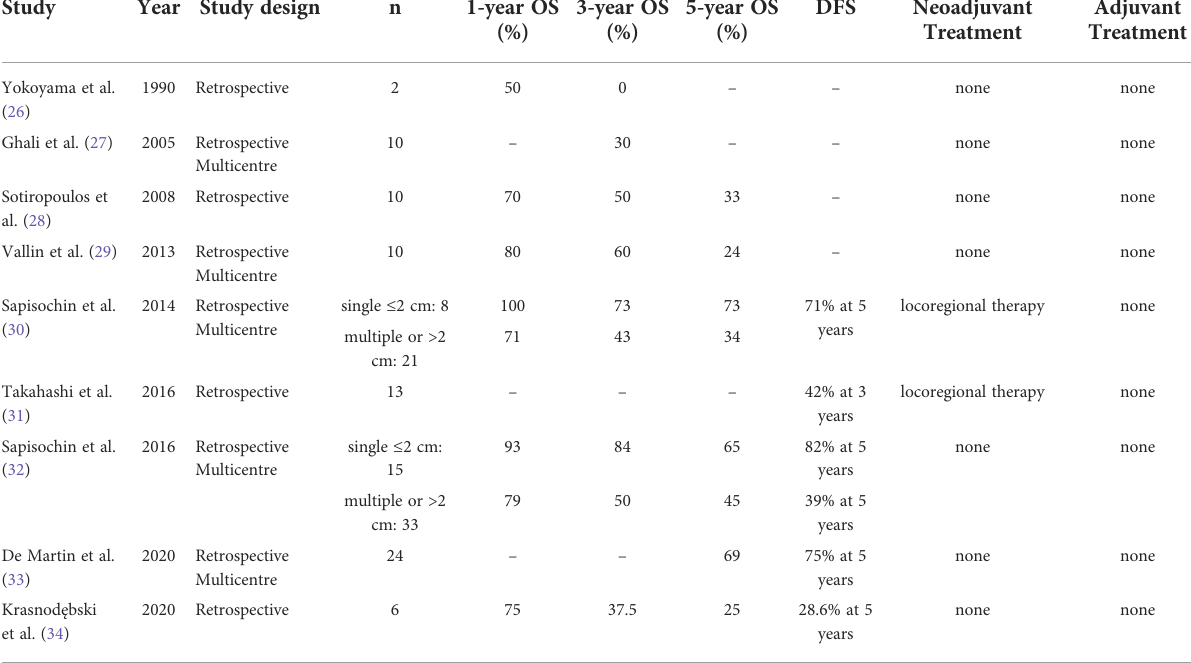
TABLE 1 Case series on liver transplantation for incidentally discovered intrahepatic cholangiocarcinoma.